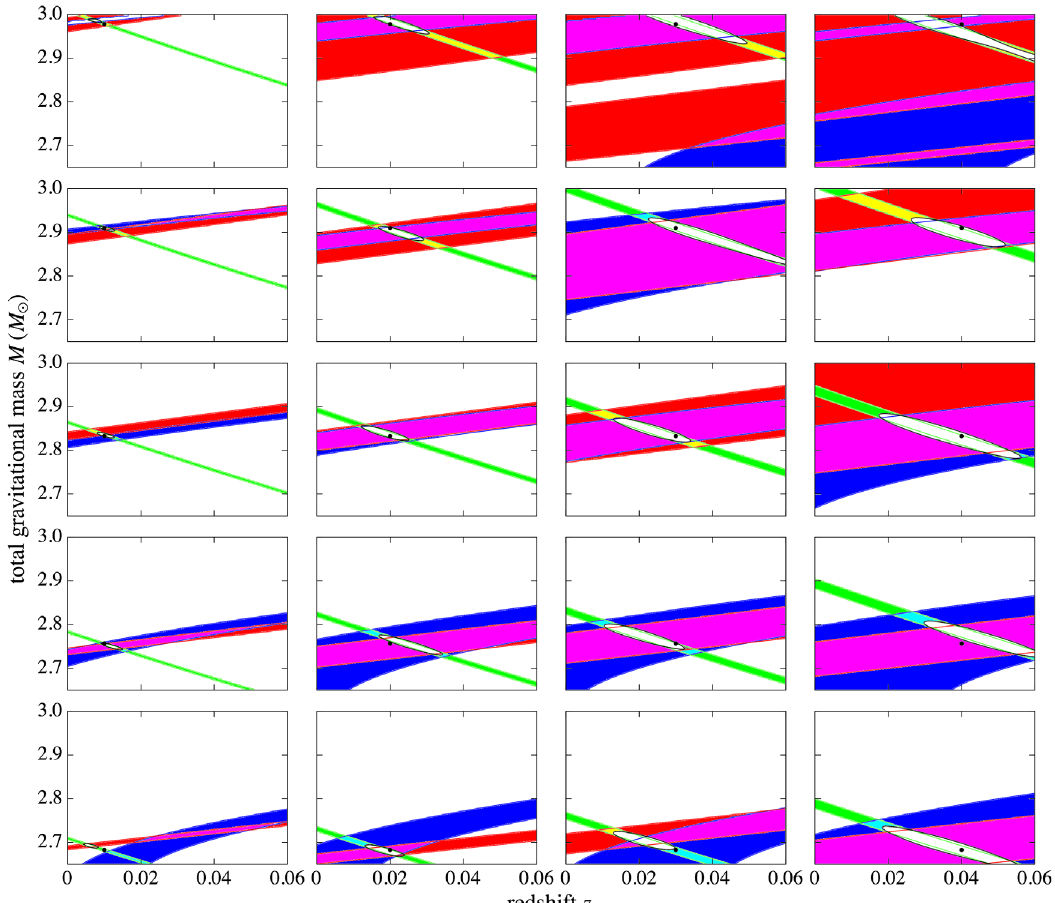
FIG. 4. The joint posterior distributions on the redshift and total gravitational mass of the BNS system for single representative realizations of noise and system parameters. Each row of plots represents a simulated signal of one of the five system masses (see Table I) ranging from low (bottom row) to high (top row) mass. Columns represent different simulated redshifts ranging from 0.01 (left) to 0.04 (right) in steps of 0.01. The green, blue, and red contours represent the posterior contributions from the inspiral measurement, the first HMNS spectral feature, and the second HMNS spectral feature, respectively. The black contours represent the final posterior distribution combining all measurements, and the black dots indicate the true simulated redshift and total mass values. In all cases, the contours enclose 68% of the probability. Overlapping regions have been filled according to the additive color system with the exception that regions outside all contours and the full interior of the final posterior contour have been left blank for